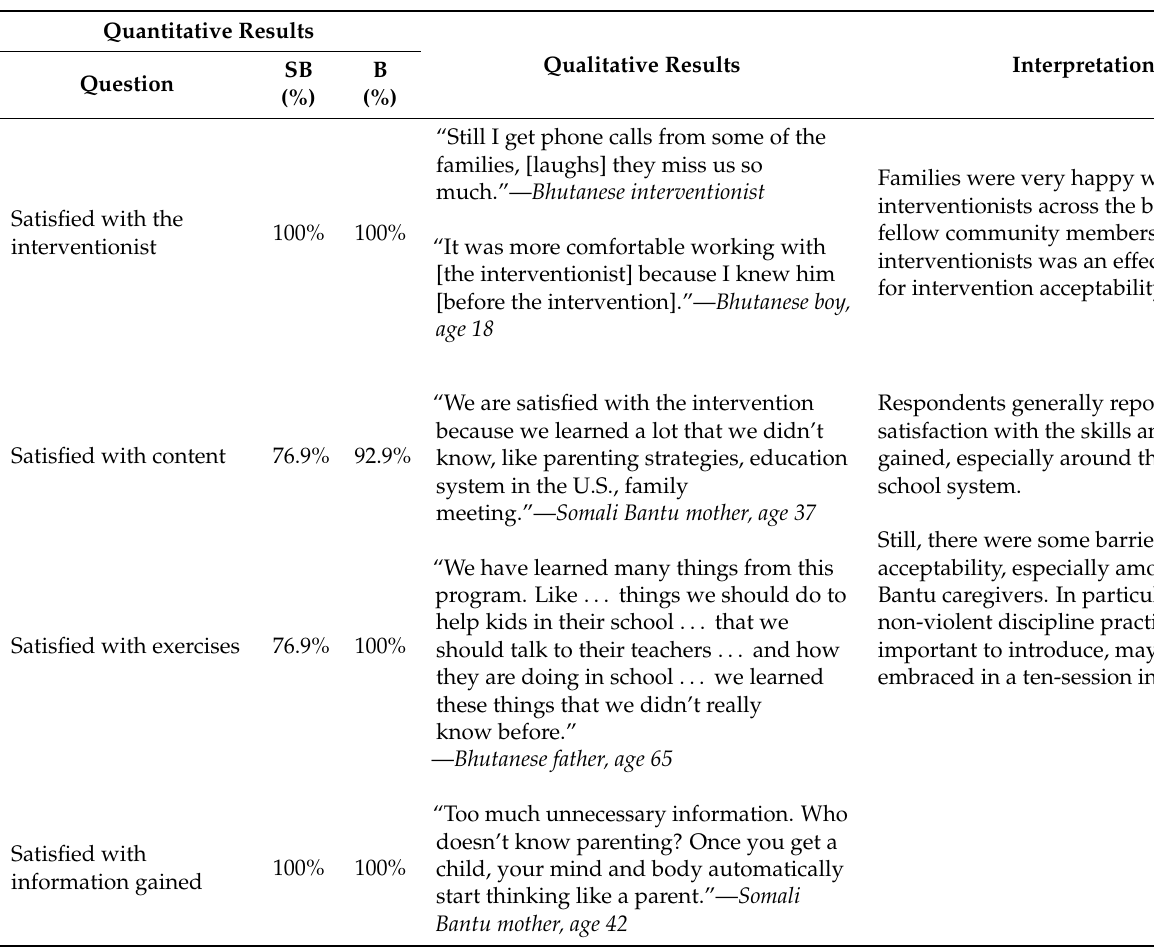
Table 5. Joint display table: Integration of quantitative (percent of caregivers reporting construct) and qualitative (interview data) about acceptability of the intervention